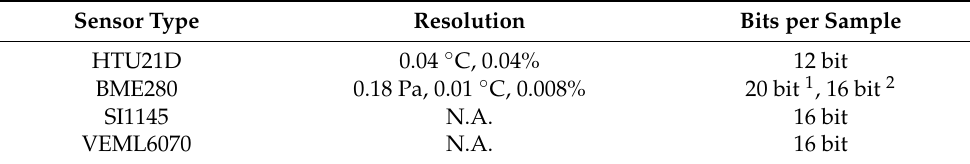
Table 13. Resolution of sensors selected for the use in the flying weather station.